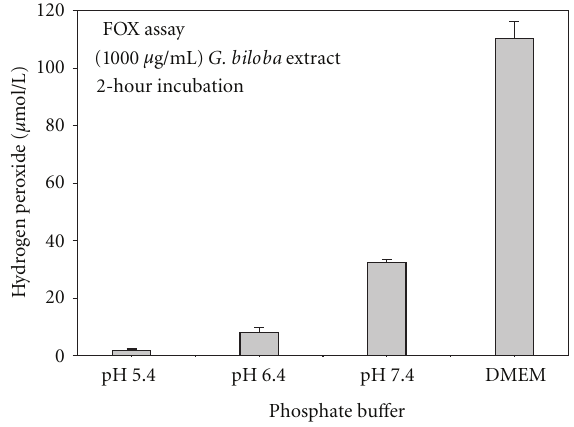
Figure 2: Comparative generation of hydrogen peroxide (H 2 O 2 ) in phosphate bu ff er, maintained at di ff erent pH levels, and in cell culture medium supplemented with Gingko biloba extract. The Dulbecco’s modified Eagle medium (DMEM) in this study was amended 10% Serum Plus, 2% fetal bovine serum, and antimicrobial agents and was the medium in which the cells were exposed to the test agents. H 2 O 2 , generated by the plant extract, was quantified with the FOX assay, after a 2-hour incubation at room temperature. Data, from Babich et al. [13], are presented as the mean percent of H 2 O 2 ± S.E.M.